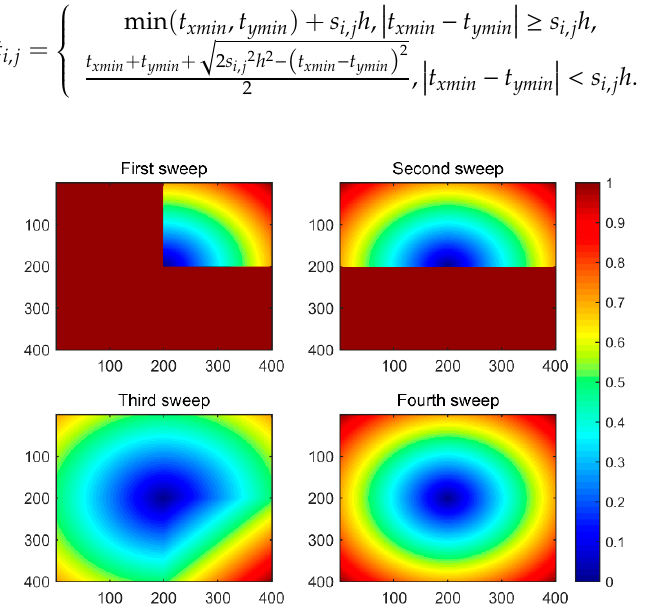
Figure 2. Four sweep processes of the FSM.